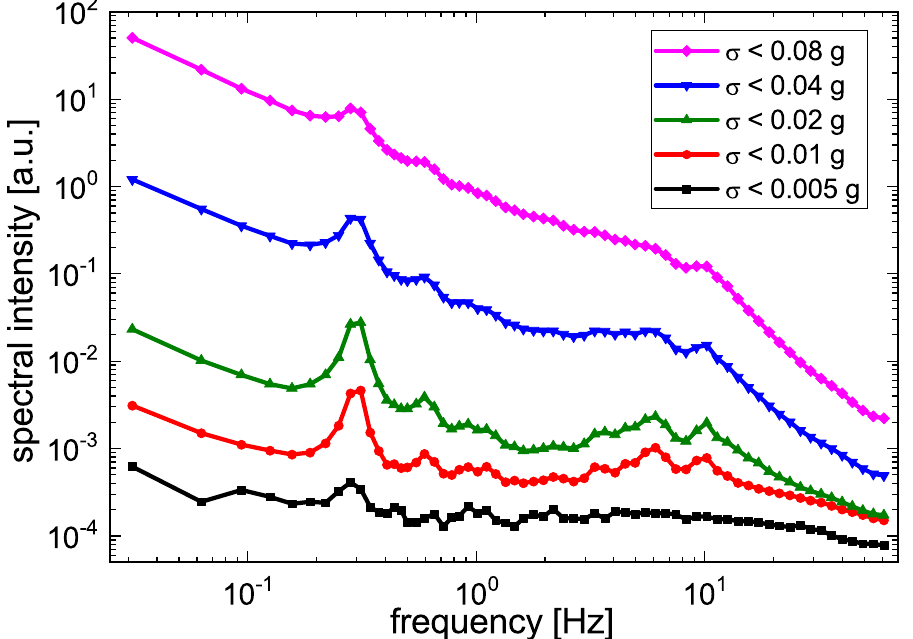
Fig 1. Spectral intensity of wrist acceleration during different levels of motion activity. Periodograms are shown for five exponentially increasing acceleration variance thresholds (black: smallest threshold; magenta: largest threshold). Peaks related with respiratory motion (at � 0.3 Hz) and pulse waves (at � 6 − 10 Hz) are most clearly visible for intermediate acceleration variance levels (red and green curves) (after [6]).